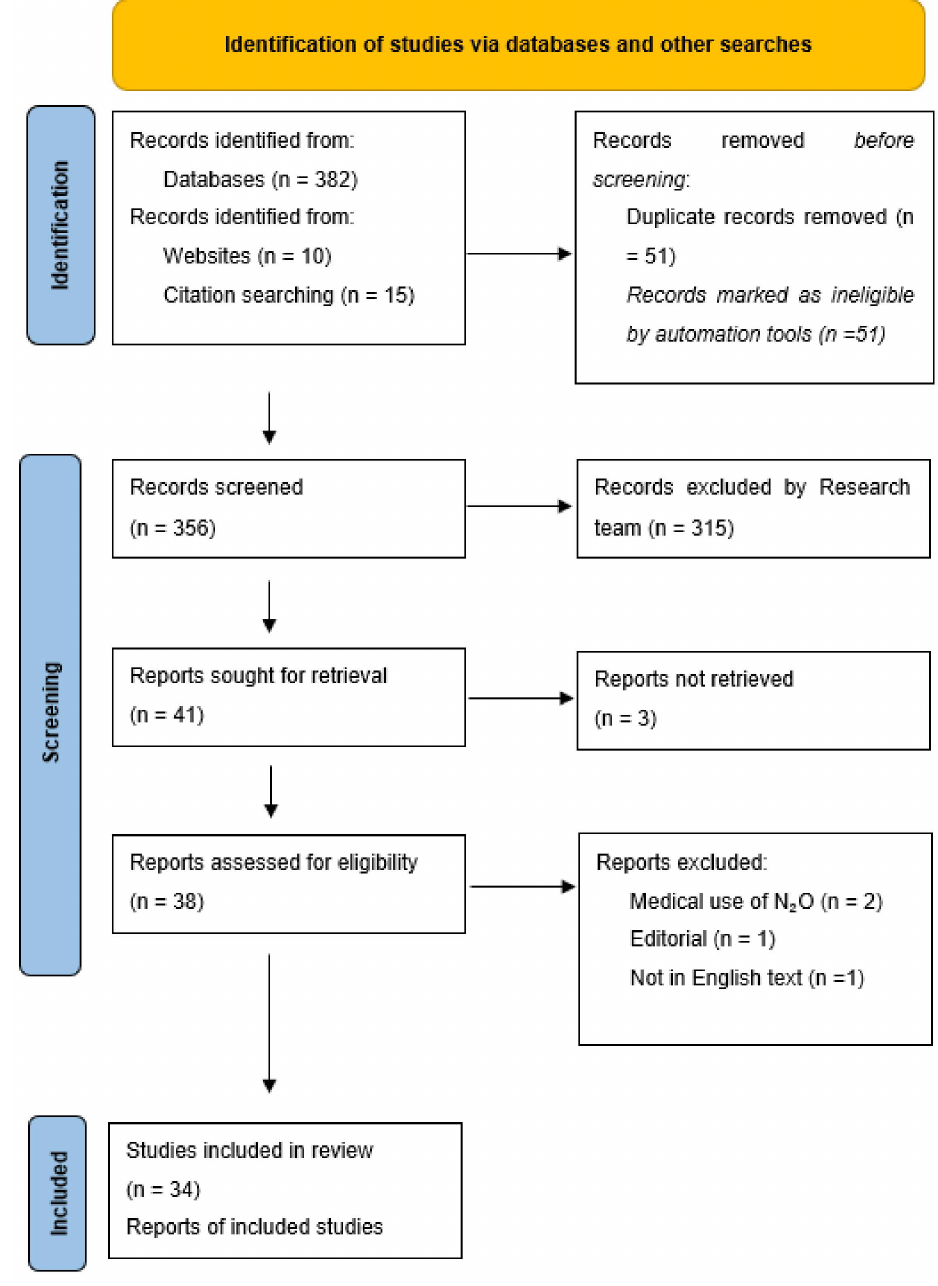
Figure 1. PRISMA Flow